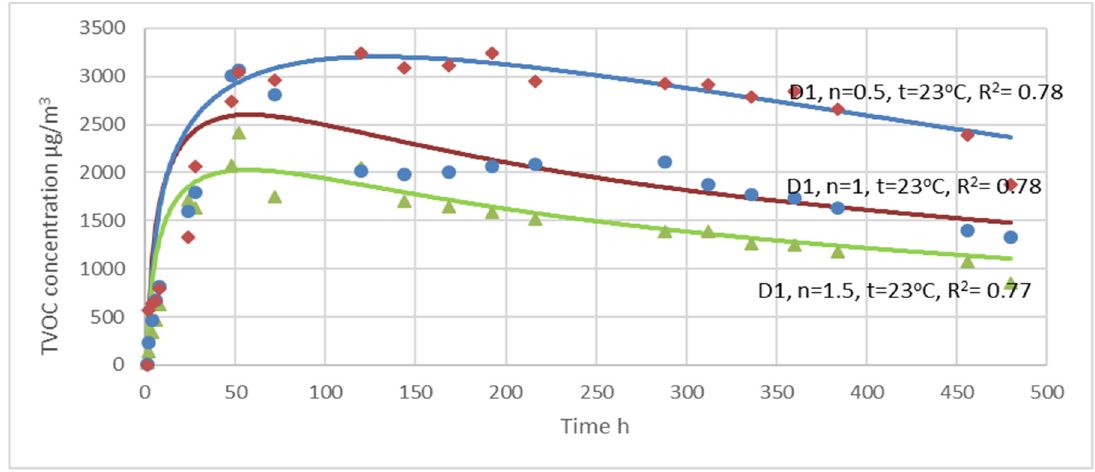
Figure 11. The TVOC emission profiles from D1 sandwich floor systems (tested for 480 h) for three air changes rates ( n =0.5 h − 1 , 1 h − 1 and 1.5 h − 1 ) at 23 °C and RH = 50% in the test chamber. (D1 sample is a floor system made of: polyurethane solvent primer and polyurethane adhesive (see Table 3); significant VOCs compounds for products are in Table 1).